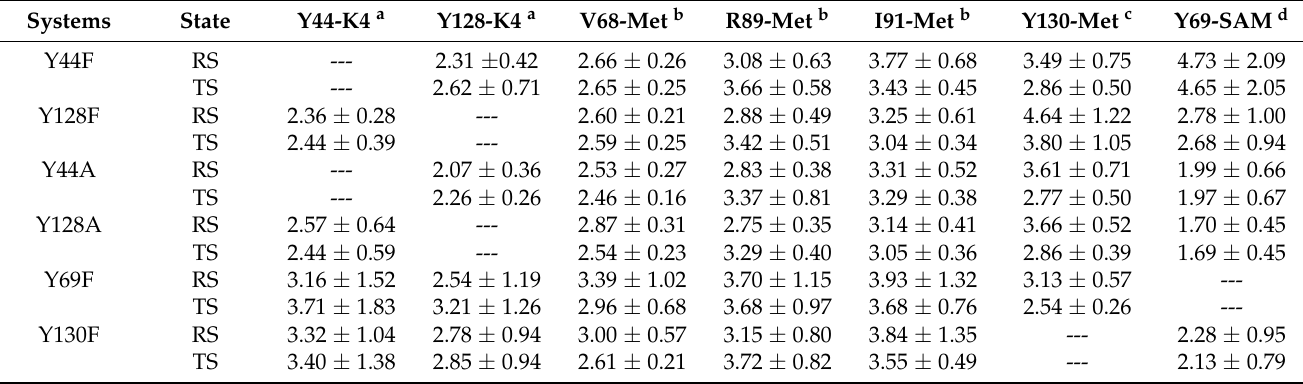
a Distance between hydroxyl oxygen from Tyr and the closest proton from Lys4. b Distance between carboxyl oxygen obtained from the backbone of the residue and the closest hydrogen obtained from Met. c Distance between the hydroxyl oxygen obtained from Tyr and the closest hydrogen obtained from Met. d Distance between the hydroxyl group obtained from Tyr69 and the closest oxygen obtained from the carboxylic acid of SAM. e Data obtained from reference [21]. --- means no data in the column in the table.